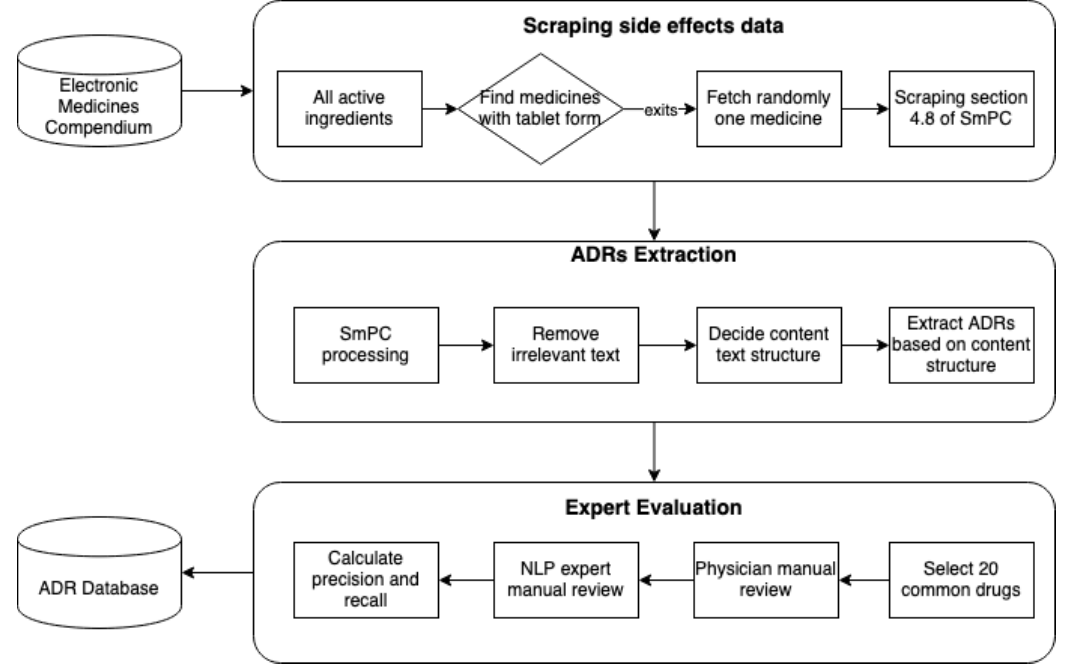
Figure 1. A conceptual overview of the automatic Adverse Drug Reactions (ADRs) extraction